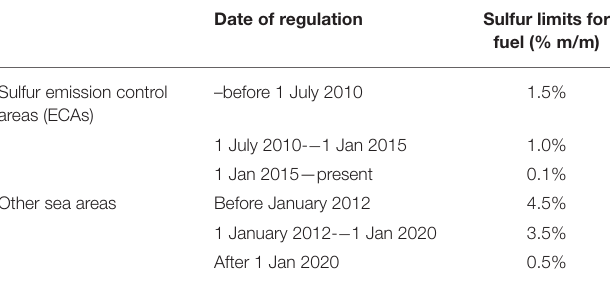
TABLE 1 | History of sulfur limits for shipping fuel for sulfur emission control areas (ECAs) and in all other sea